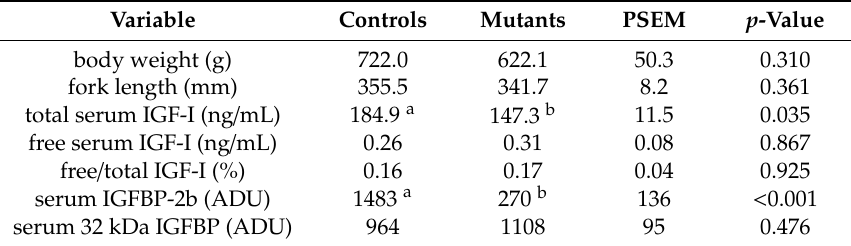
Table 1. Indices of growth performance and serum IGF-I in fed fish harvested at 15 months post hatch. Different superscript letters indicate that means differ between controls and mutants ( p < 0.05, n = 15). ADU: arbitrary density units.